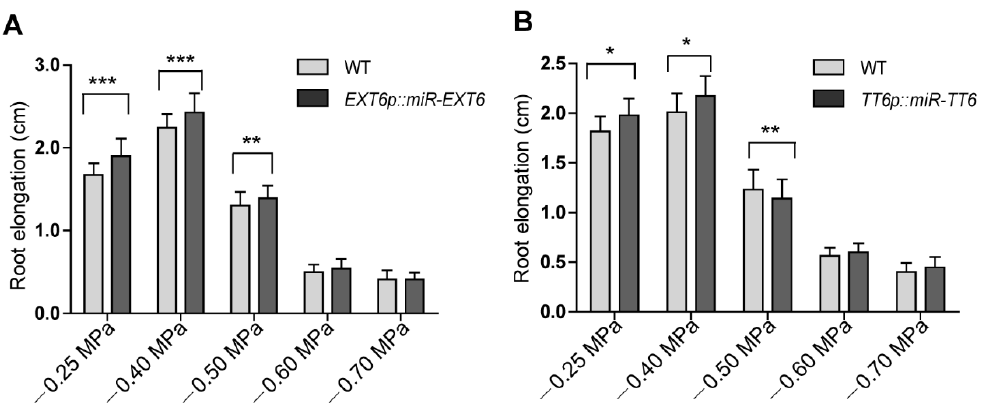
Figure 5. EXTp::miR-EXT6 and TT6p::miR-TT6 transgenic lines have longer roots under mild osmotic